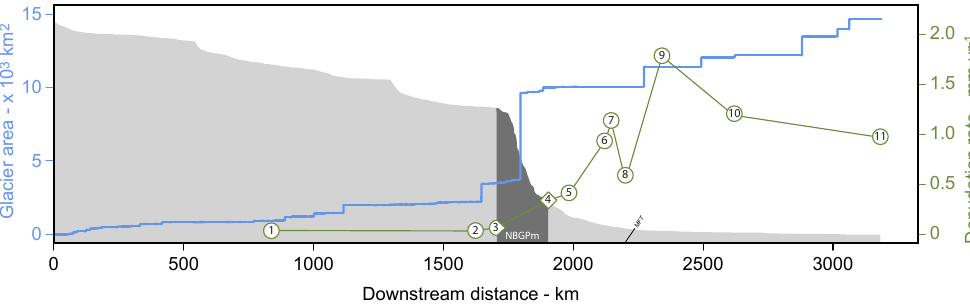
Figure 5. Downstream evolution of the total drained glaciated area (GLIMS database; Raup et al., 2007) of the Tsangpo-Brahmaputra in blue. For comparison, the evolution of the trunk channel elevation is plotted in grey and the average 10 Be denudation rate in